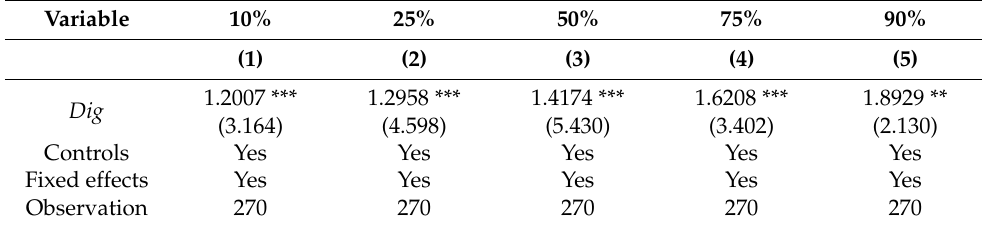
Table 10. Regression results when ACP is at different levels.